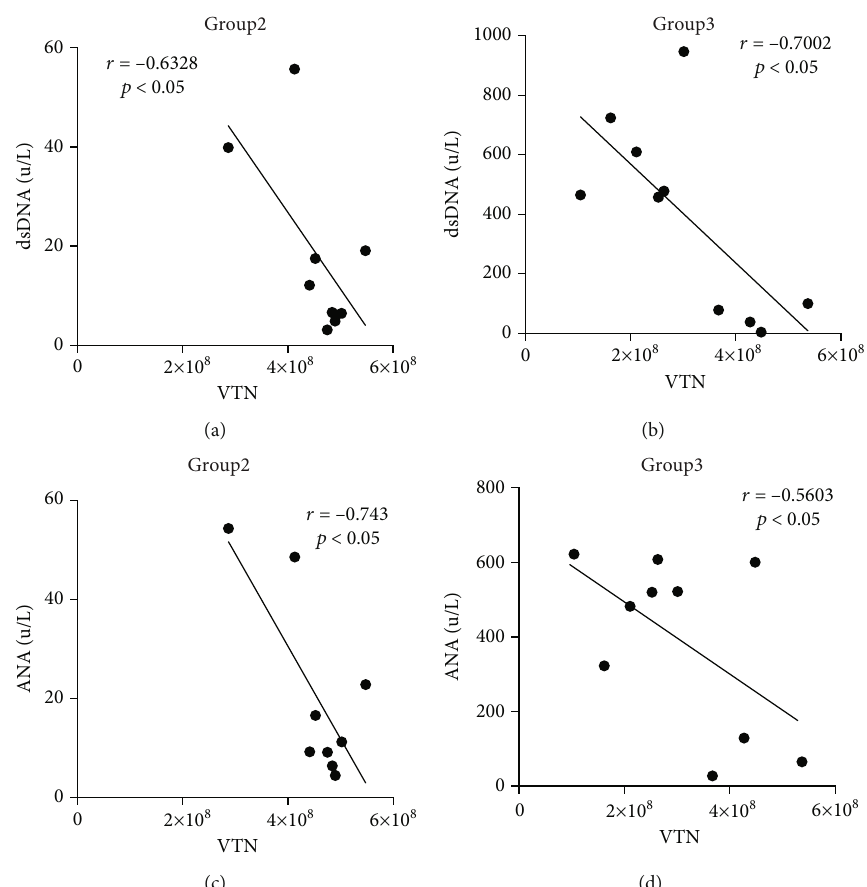
Figure 5: Clinical correlation between VTN with dsDNA, ANA, and complement C3 and C4. The dot plot shows the correlation between urinary VTN expression and (a) serum dsDNA level, (c) serum ANA level, (e) serum complement C3 level, and (g) serum complement C4 level in inactive JSLE patients, as well as the correlation between urinary VTN expression and (b) serum dsDNA level, (d) serum ANA level, (f) serum complement C3 level, and (h) serum complement C4 level in active JSLE patients (group 2: inactive JSLE patients, group 3: active JSLE